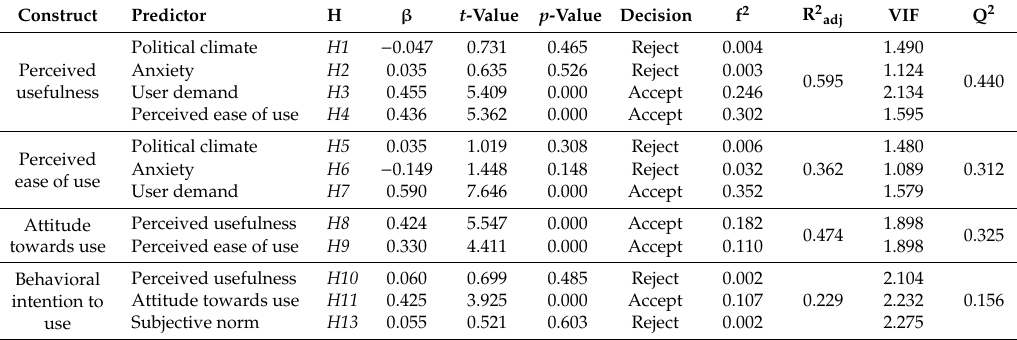
Table 12. Path Coe ffi cients and Model Quality Assessment (for